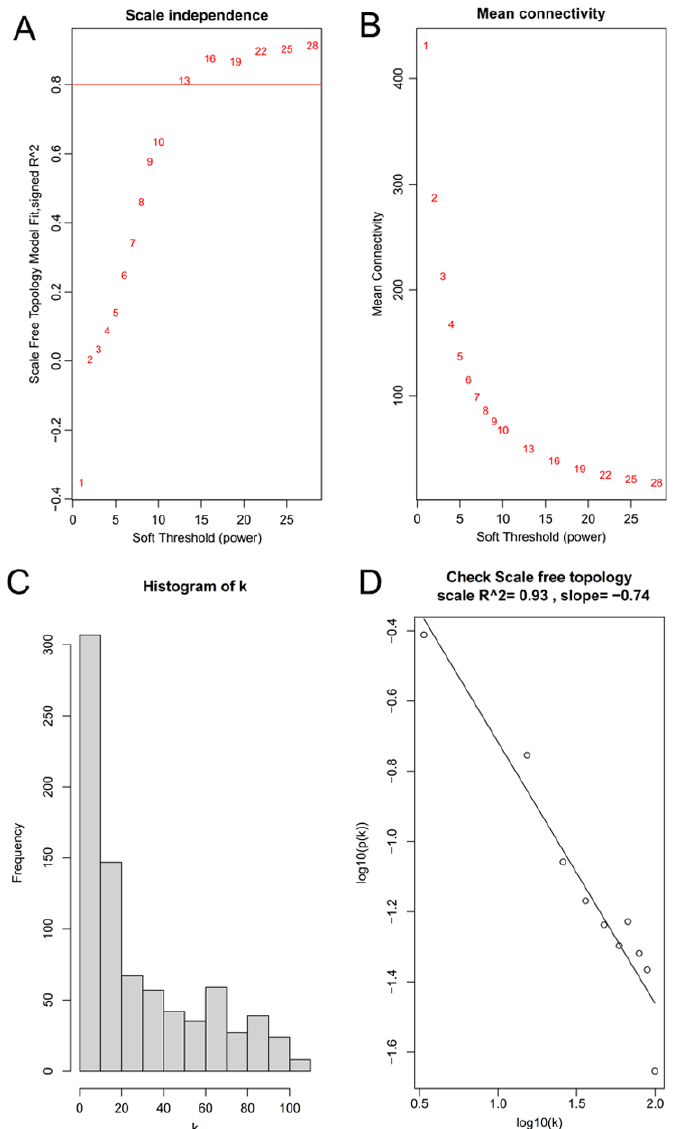
Figure 1. Determination of the best soft-threshold power in the WGCNA. ( A ) Analysis of the scale-free fit index for various soft-threshold powers (from 1 to 28); ( B ) analysis of the mean connectivity for various soft-threshold powers (from 1 to 28); ( C ) the histogram of k; ( D ), the correlation coefficient between k and p (k) to check the scale-free topology when β = 13.